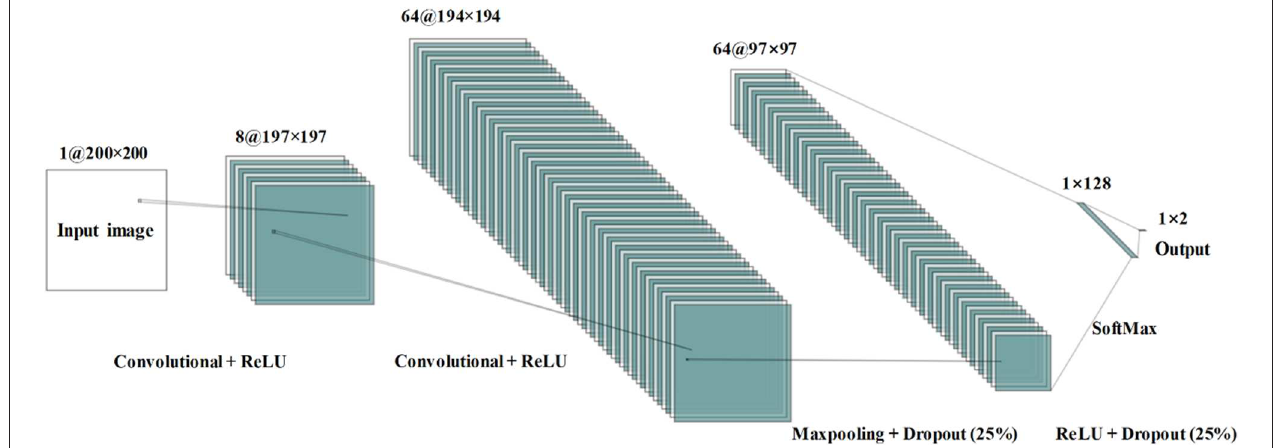
FIGURE 6 | Convolutional neural network architecture used during the study for mild cognitive impairment and healthy control classification.